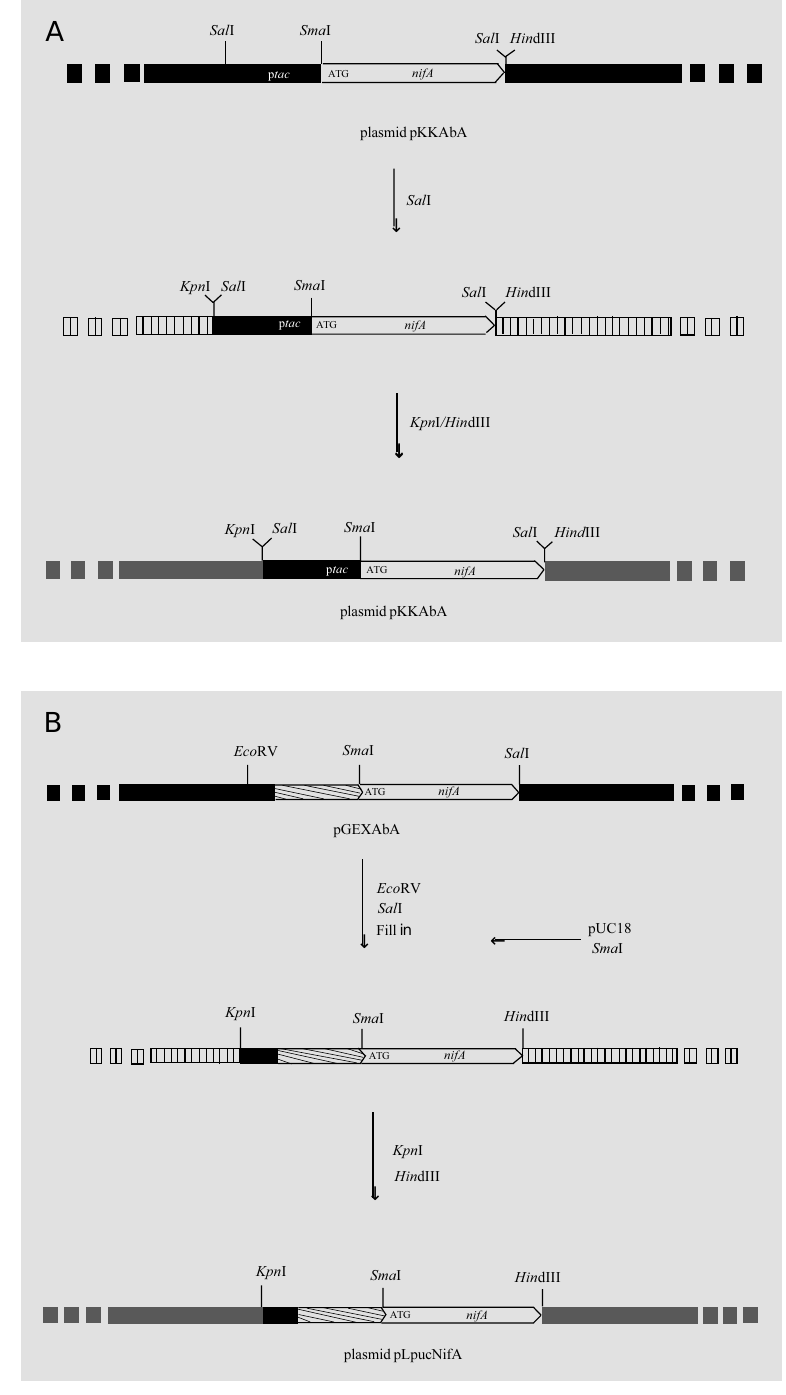
Figure 3 - Strategy for cloning the nif A gene from A. brasilense into cosmid pLAFR3. A shows the steps for cloning the transcriptional tac - nif A fusion construct, and B shows the steps for cloning the translational fusion GST-NifA. Black boxes indicate the pKK223-3 vector in A and the pGEX 4T-1 vector in B; striped boxes indicate the pBluescript vector in A and the pUC18 vector in B; gray boxes indicate the pLAFR3 vector. The stippled arrow indicates the sequence of the GST protein from vector pGEX